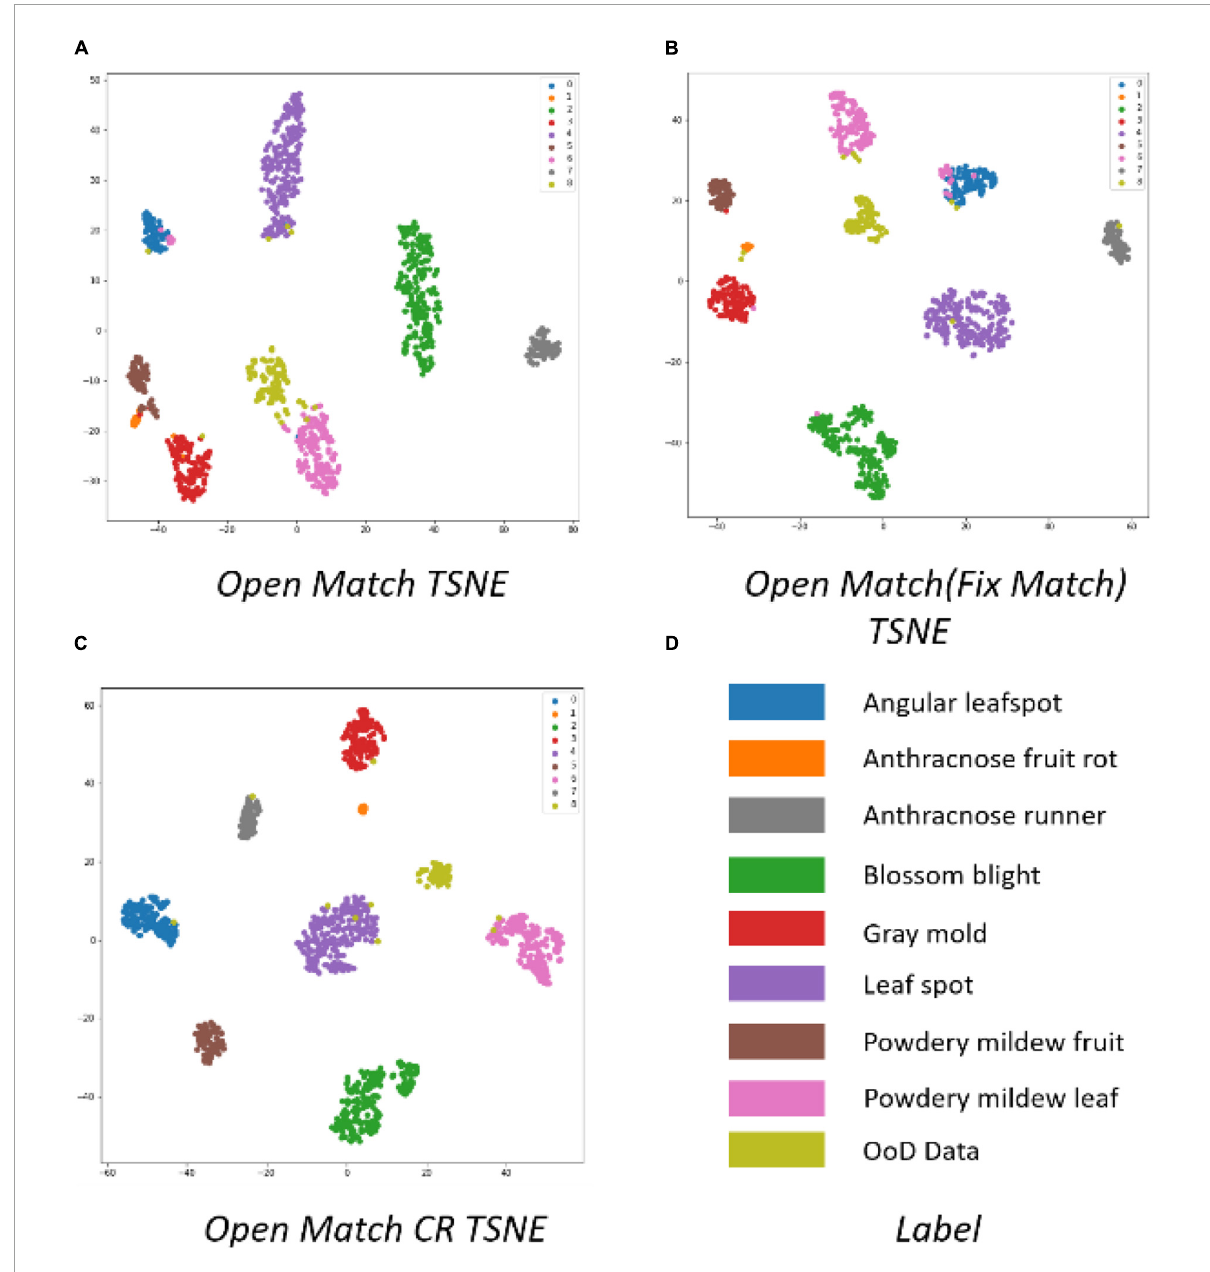
FIGURE12 Comparison of cluster structures of disassembled OpenMatch using t-SNE.